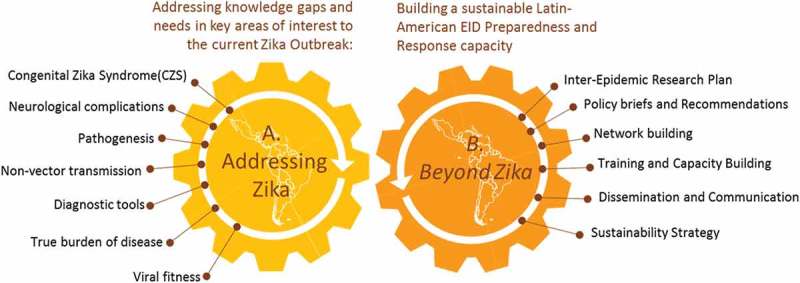
Dual purpose of ZikaPLAN.